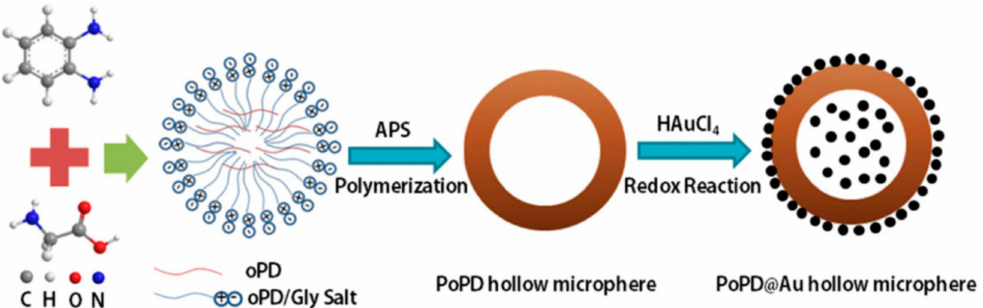
Figure 9. poly(o-phenylenediamine)/gold nanoparticle for dopamine sensing. Reprinted with permission from